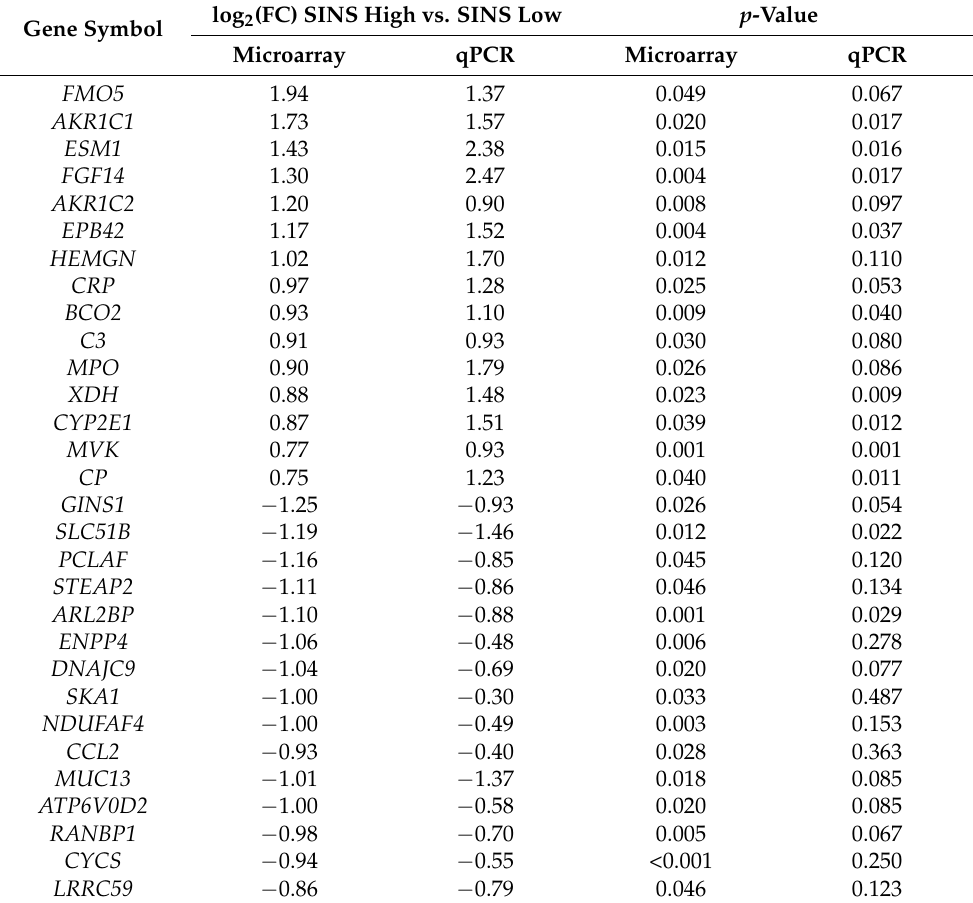
Table 2. qPCR validation of selected microarray